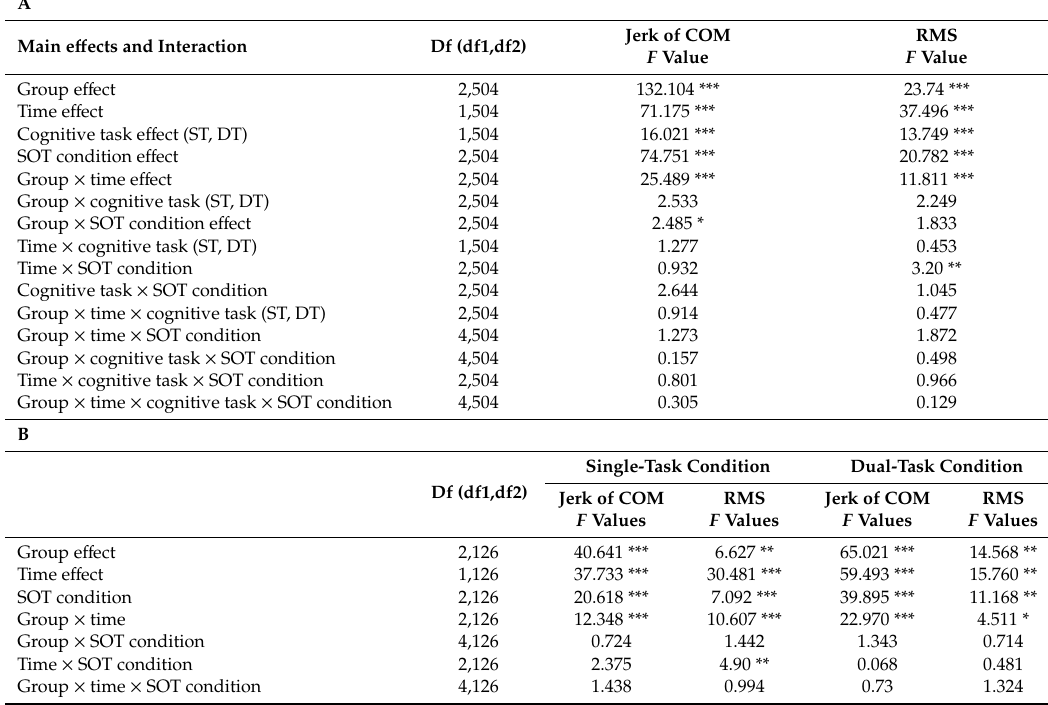
Table 3. Overall results for Jerk and RMS of COM and ANOVA results for Jerk and RMS during single- and dual-task